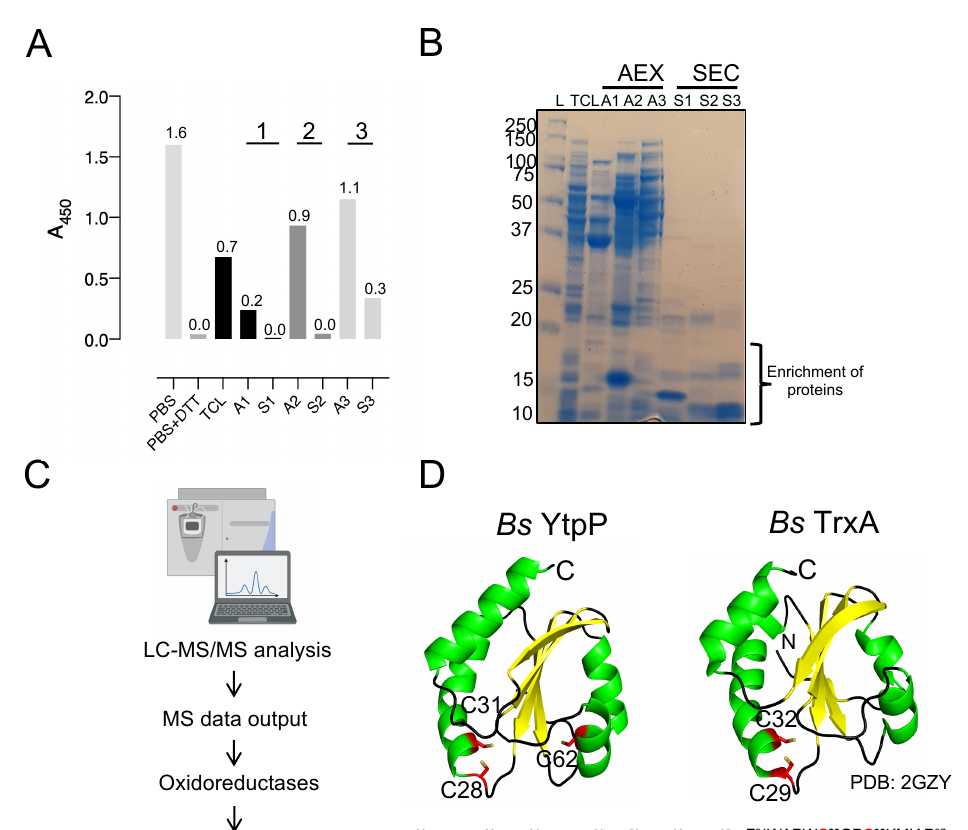
Figure 4. Identification of protein candidates with protein deCoAlation activity. ( A ) The bar graph shows the enrichment of deCoAlation activity after each purification step: AEX chromatography fractions (A1, A2, and A3) and SEC (S1, S2, and S3). For each sample, A 450 nm is indicated on top of each bar graph. The graph was generated by GraphPad Prism8 (version 8.3.1). For the A1, A2, and A3 absorbances, it is a representation of the average absorbance of the pooled fractions. ( B ) The purity of the AEX (A1, A2, and A3) and SEC (S1, S2, and S3) purification fractions are shown on an SDS-PAGE gel. The gel is stained with InstantBlue. ( C ) The purified fractions were analyzed via LC-MS/MS, and candidates were selected based on 3 criteria: belong to the oxidoreductase family, have cysteine residues, and have a specific molecular mass. Based on these criteria, YtpP and TrxA were selected as candidates. ( D ) The AlphaFold structure of B. subtilis YtpP is shown in cartoon form [37,38]. It has three cysteine residues (C28, C31, and C62) and a Trx-fold with a CXXC motif. The B. subtilis TrxA (PDB: 2GZY) structure is shown in cartoon form. The two structures have a CXXC motif and a Trx-fold. The Cys residues are shown in red and labeled. The sequences surrounding the CXXC motifs are shown below the